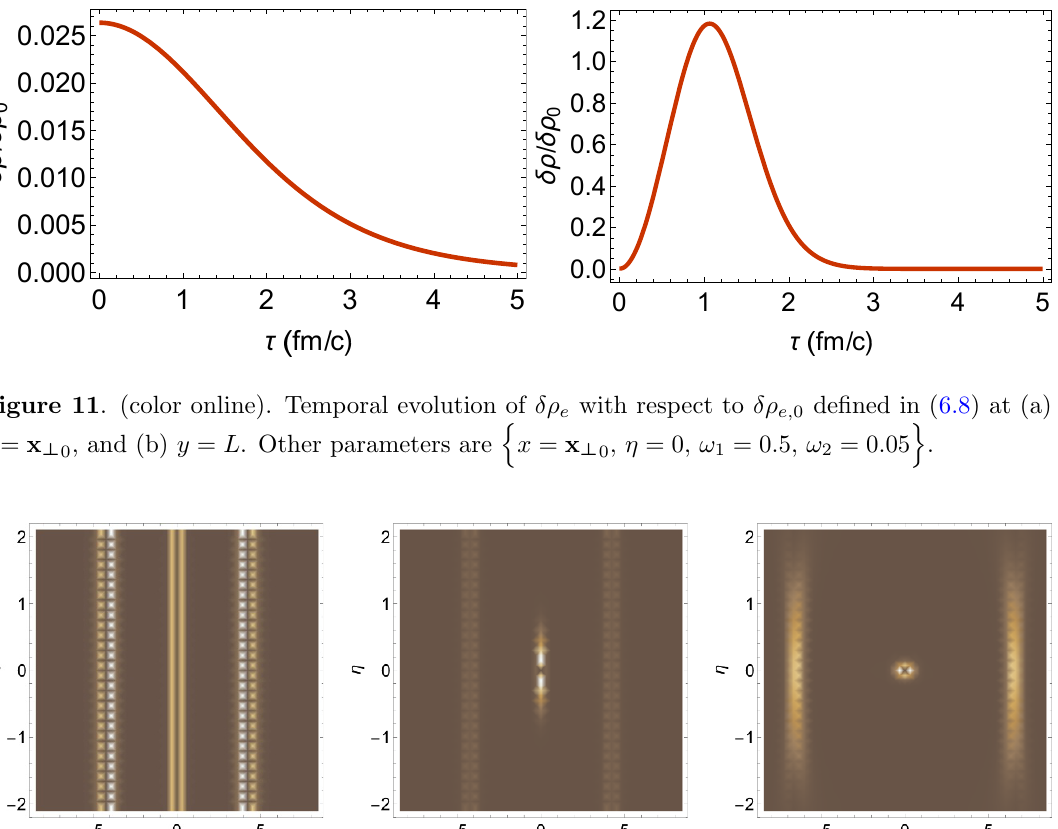
Figure 12 . (color online). (cid:14)(cid:26) in the y (cid:0) (cid:17) plane at (a) (cid:28) = 0, (b) (cid:28) = 0 : 4 fm = c, and (c) (cid:28) = 5 fm = c. The value of (cid:14)(cid:26) is multiplied by 10 7 to make the picture more clear. Other parameters are